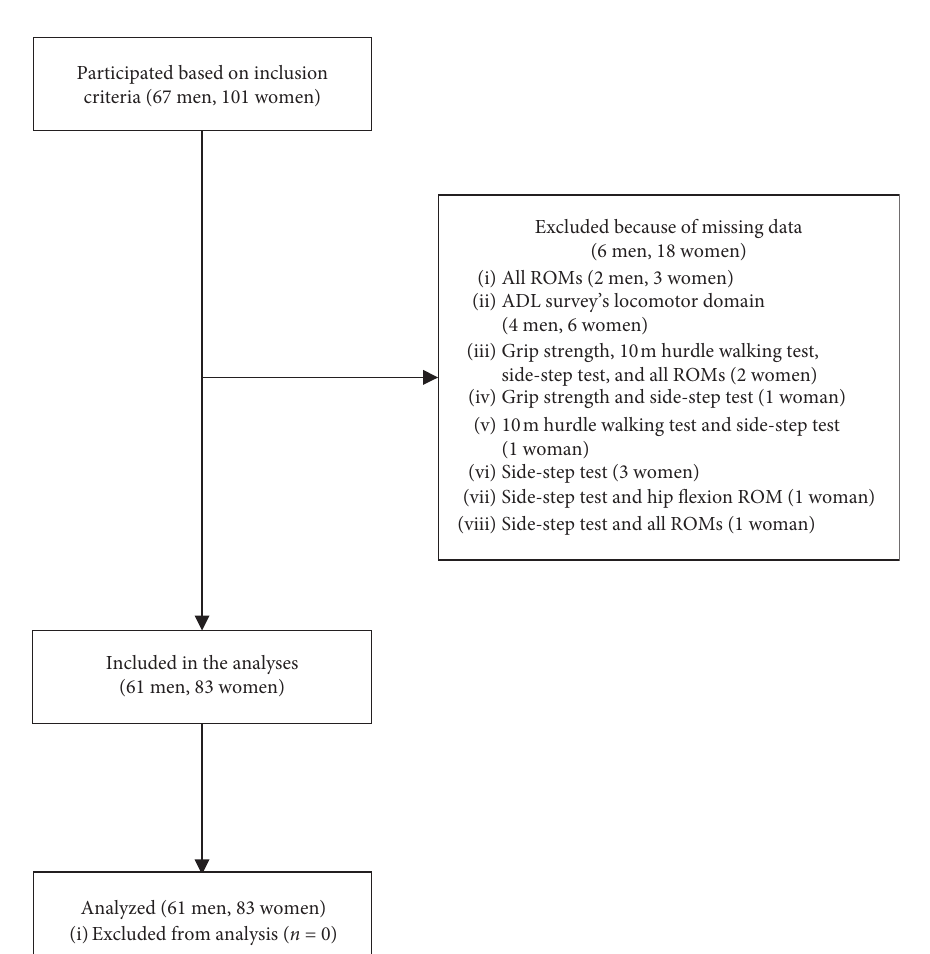
Figure 1: Flow diagram of the selection process of the participants. ADL, activities of daily living. ROM, range of